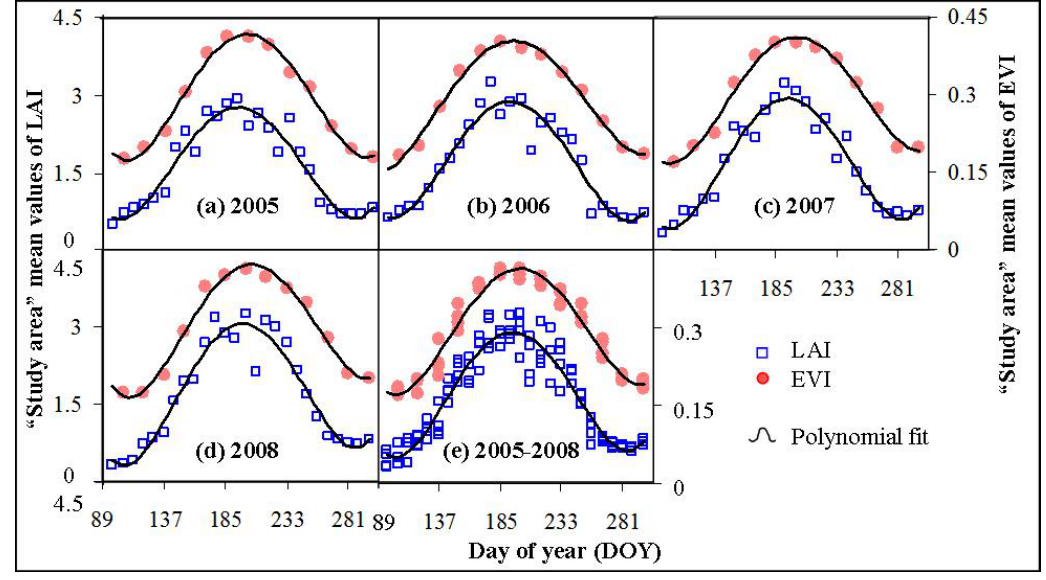
Figure 3. Temporal behaviour of LAI and EVI for the April–October period (DOY 97–297) of (a) 2005, (b) 2006, (c) 2007 and (d) 2008, and for (e) all years (2005–2008).